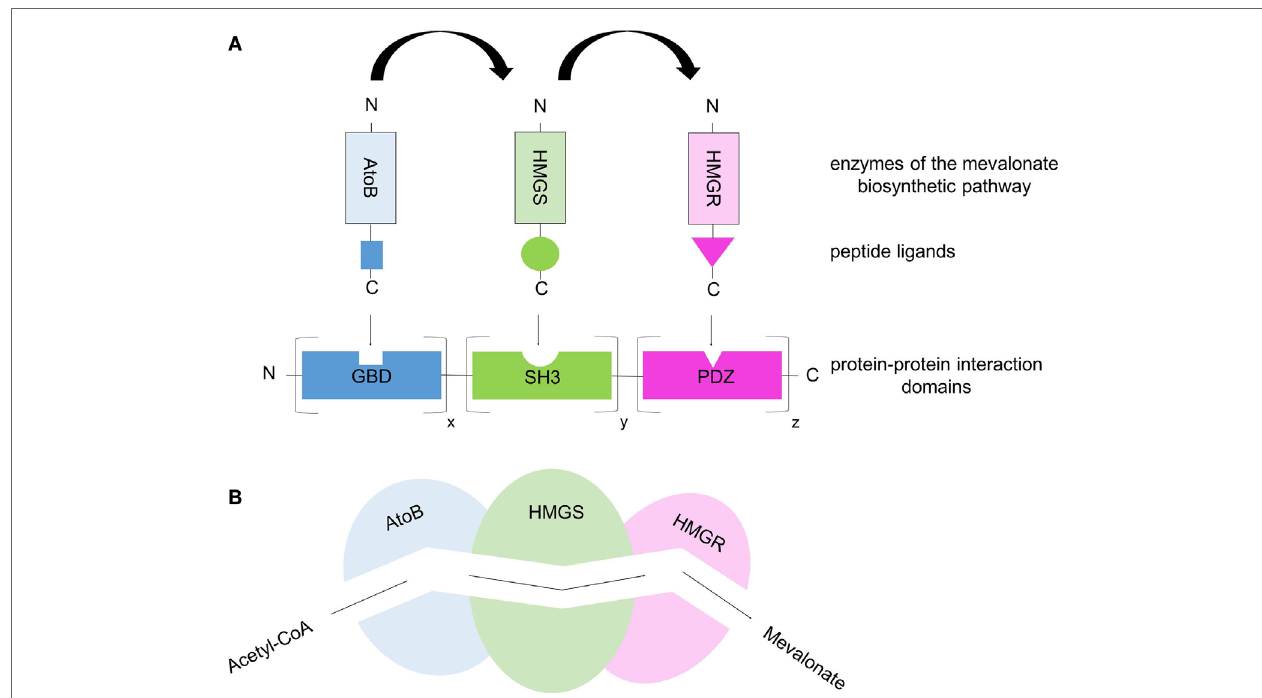
FiGURe 4 | Protein-scaffold-based multienzyme complex offers a synthetic metabolic pipeline that allows substrate channeling . (A) The three enzymes of the mevalonate biosynthetic pathway (acetoacetyl-CoA thiolase, AtoB; hydroxy-methylglutaryl-CoA synthase, HMGS; hydroxy-methylglutaryl-CoA reductase, HMGR) were co-localized on a synthetic protein-scaffold via high-affinity interactions between protein domains and their specific, cognate peptide ligands. The protein scaffold consists of various repeats of well-characterized, metazoan protein domains (SH3, GBD, PDZ) and the corresponding peptide ligands are fused to the enzymes. By co-expressing the synthetic scaffold and the enzyme–peptide ligand fusions in E.coli cells, the three enzymes are targeted to the scaffold building a multienzyme complex. Through the variation of the binding domain repeats the ratio/stoichiometry of enzymes can be controlled. (B) Simplified scheme of substrate channeling through a tunnel/metabolic pipeline connecting the active sites of the co-localized